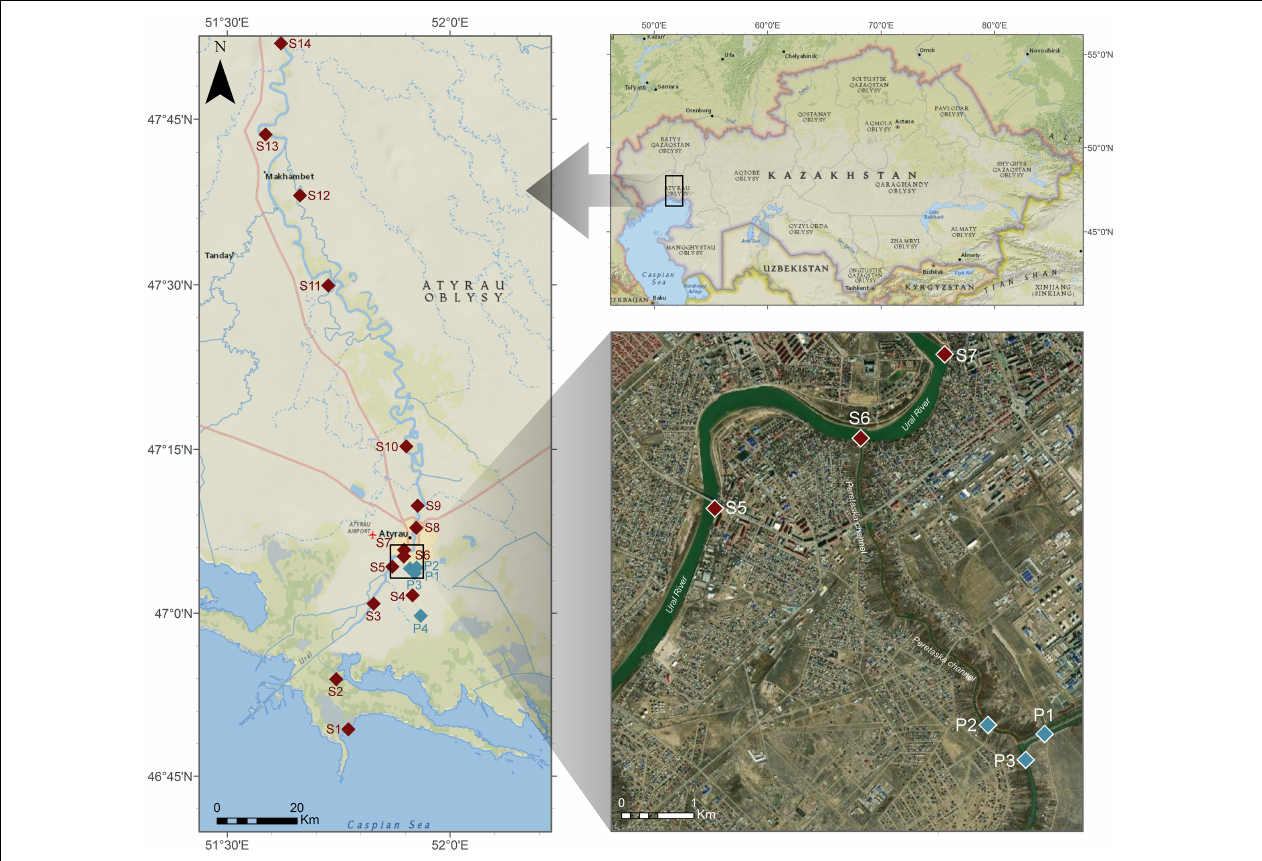
FIGURE 1 | Representation of sampling points on the Ural River. Sampling points from S1 to S3 were taken near the Ural delta, sampling points S4–S9 were taken within the city boundaries, where most of the fish die-off happened at the end of 2018–beginning 2019, sampling points S10–S14 were taken above the city boundaries upstream of the Ural River. Sampling points P1–P4 are taken during October 2019